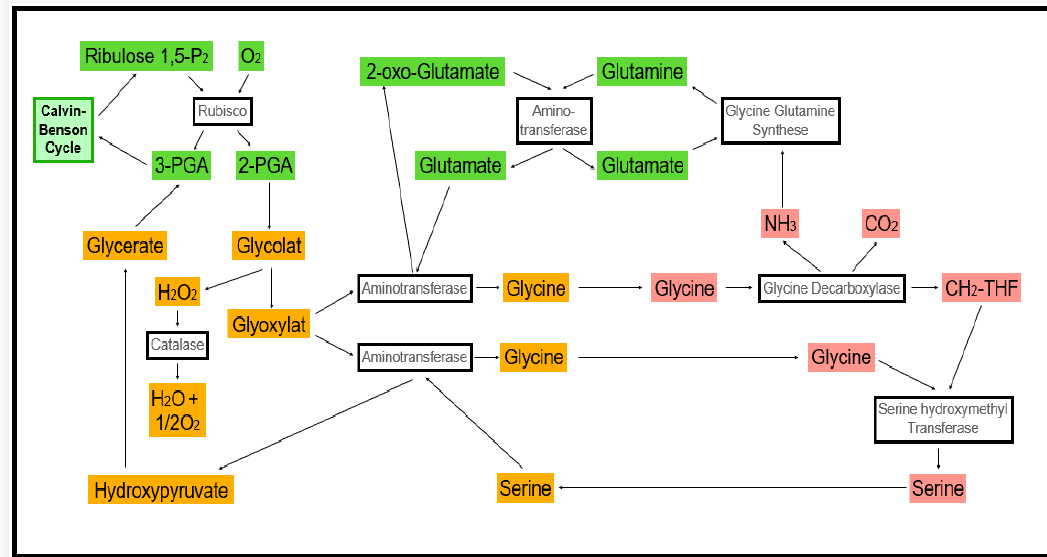
Figure 1. Metabolic interaction of cell compartments during photorespiration.